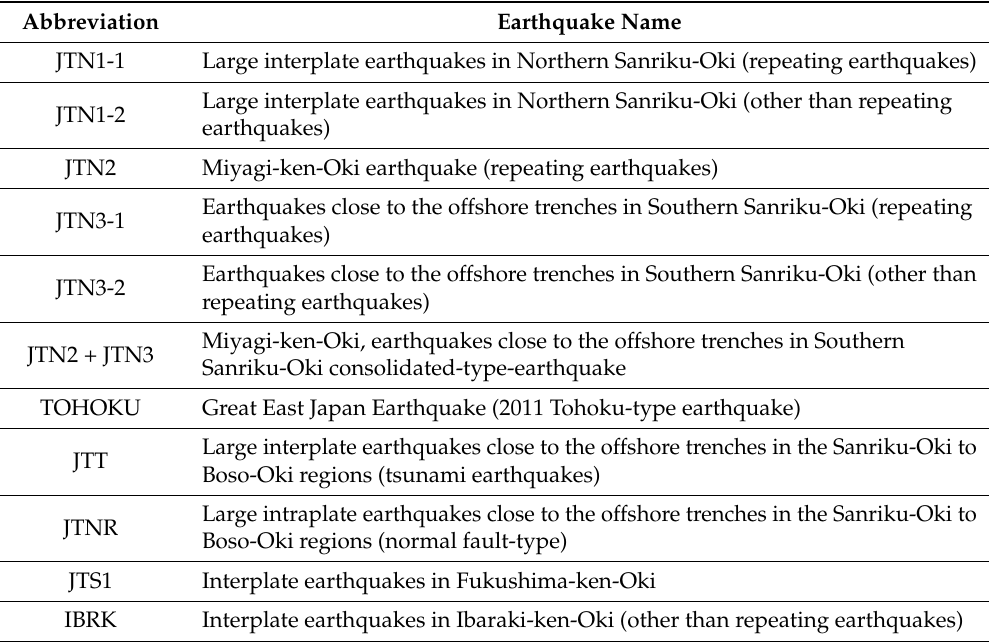
Table 2. Abbreviation